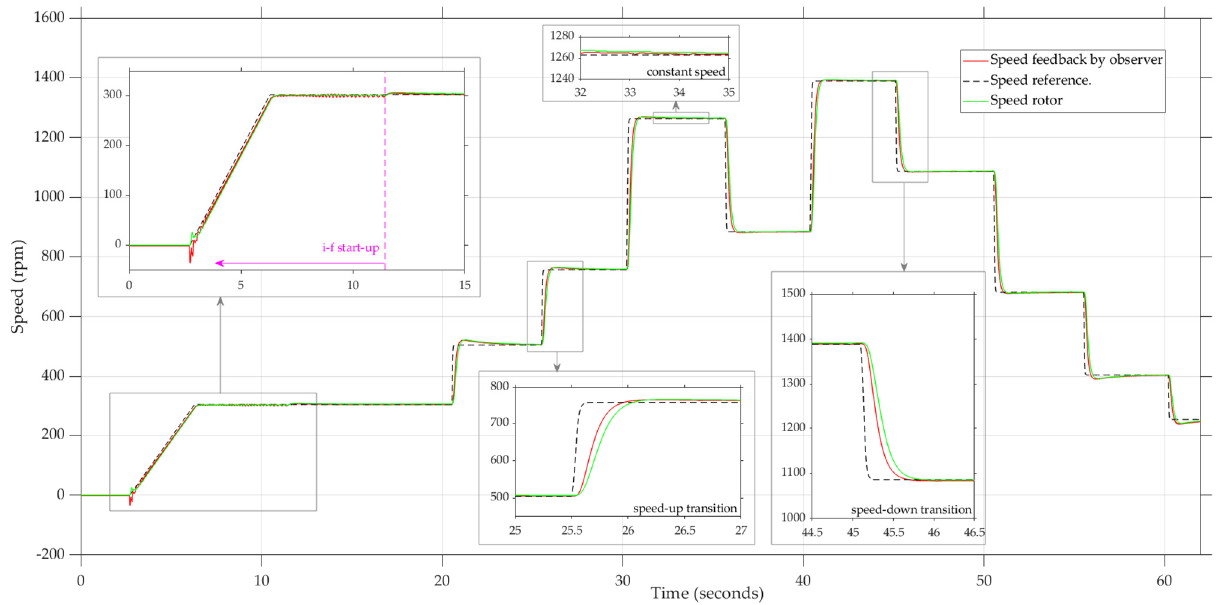
16 of 20 ( c ) Figure 17. Experimental results for the rotor position at ( a ) 400 rpm, ( b ) 760 rpm and ( c ) 1265 rpm. Figure 18 shows in the sensorless mode, the proposed observer produced speed feed-